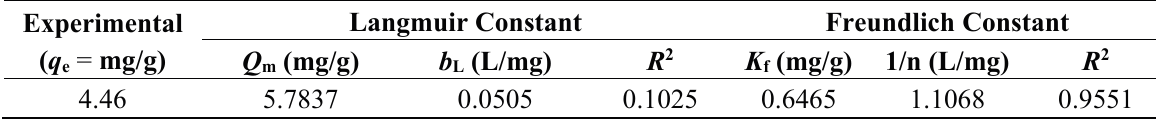
Figure 7. Langmuir ( a ) and Freundlich ( b ) plots for the sorption of Hg(II) by MIP. Table 1. Langmuir and Freundlich adsorption constants for the MIP